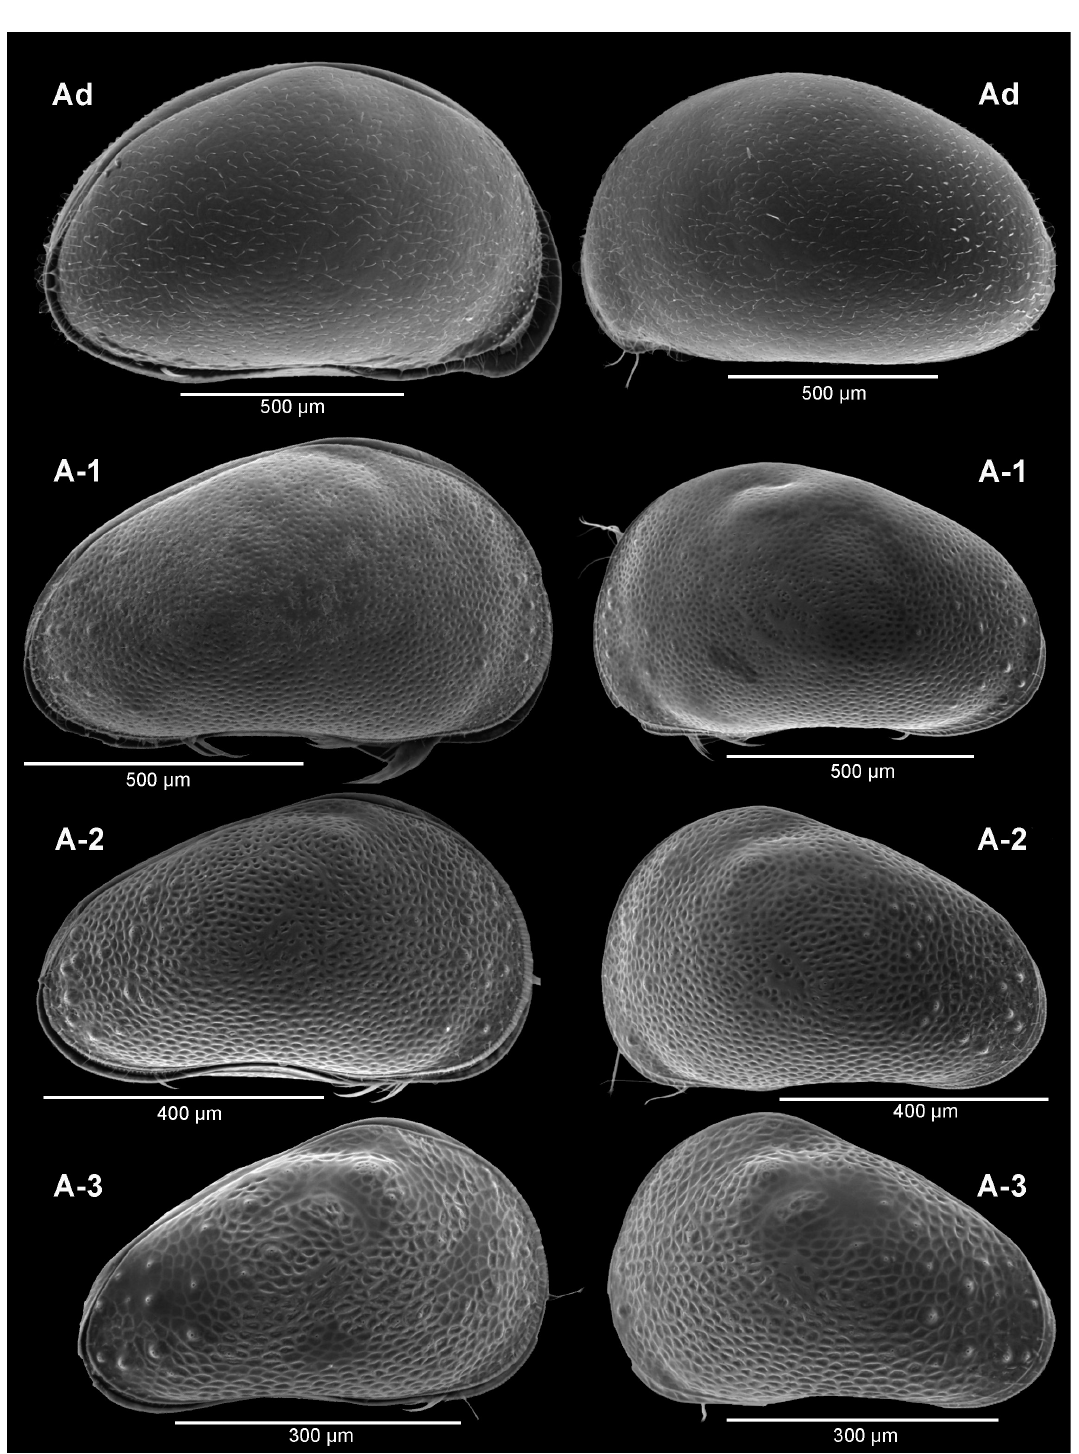
Fig. 16. Lateral views of carapaces of Bennelongia cf. barangaroo nov. sp. from McNeil Claypan. Left column displays carapace in right lateral view, right column shows carapaces in left lateral view. Note the pronounced asymmetry between the adult valves and the less-pronounced beak-like feature of the anteroventral region of the adult LV. Pseudo-punctation is more pronounced in the younger instars and the domes and cones are only clearly visible in A-3 specimens, although remnants remain in the last two juvenile